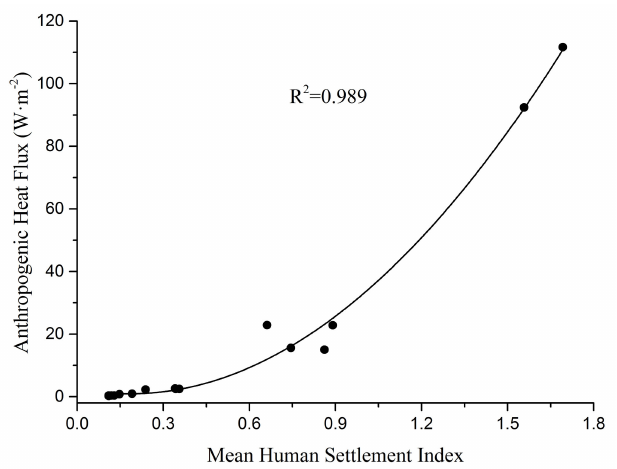
Figure 3. The statistical regression relation between the annual mean anthropogenic heat flux (AHF) and the mean human settlement index (HSI).